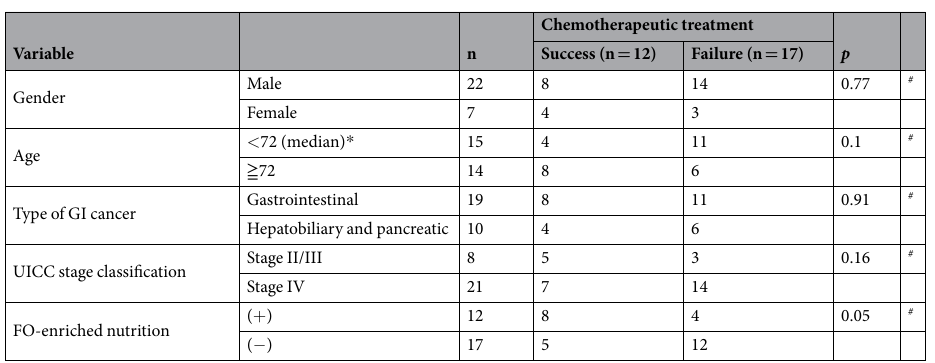
Table 3. Association between tolerance to chemotherapy and clinicopathological factors in patients with GI cancer and an mGPS of 1 or 2. * The median age at treatment was 72 years. # Chi-square